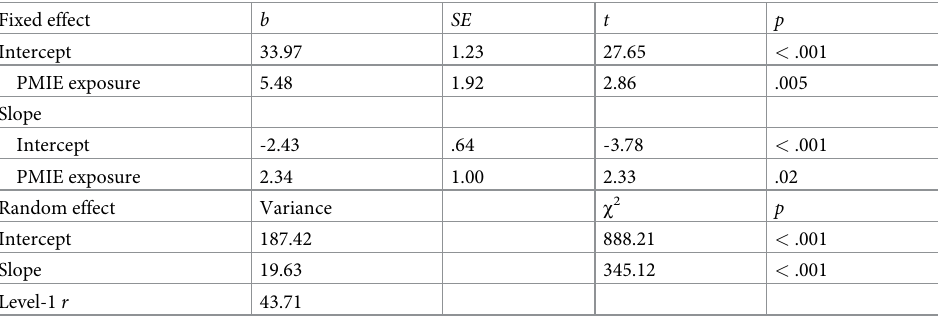
Table 2. Hierarchical linear model of the role of PMIE exposure on psychosocial functioning over the course of 10 months among healthcare providers during the COVID-19 pandemic. Fixed